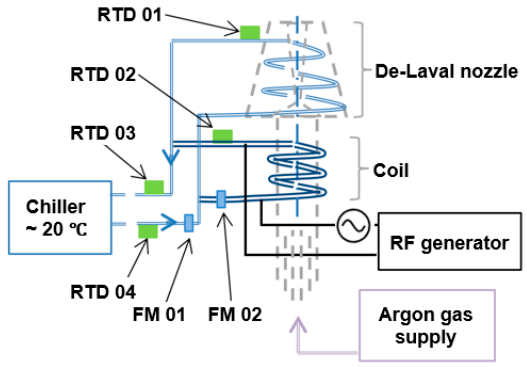
Figure 5. Plasma delivery system schematic.